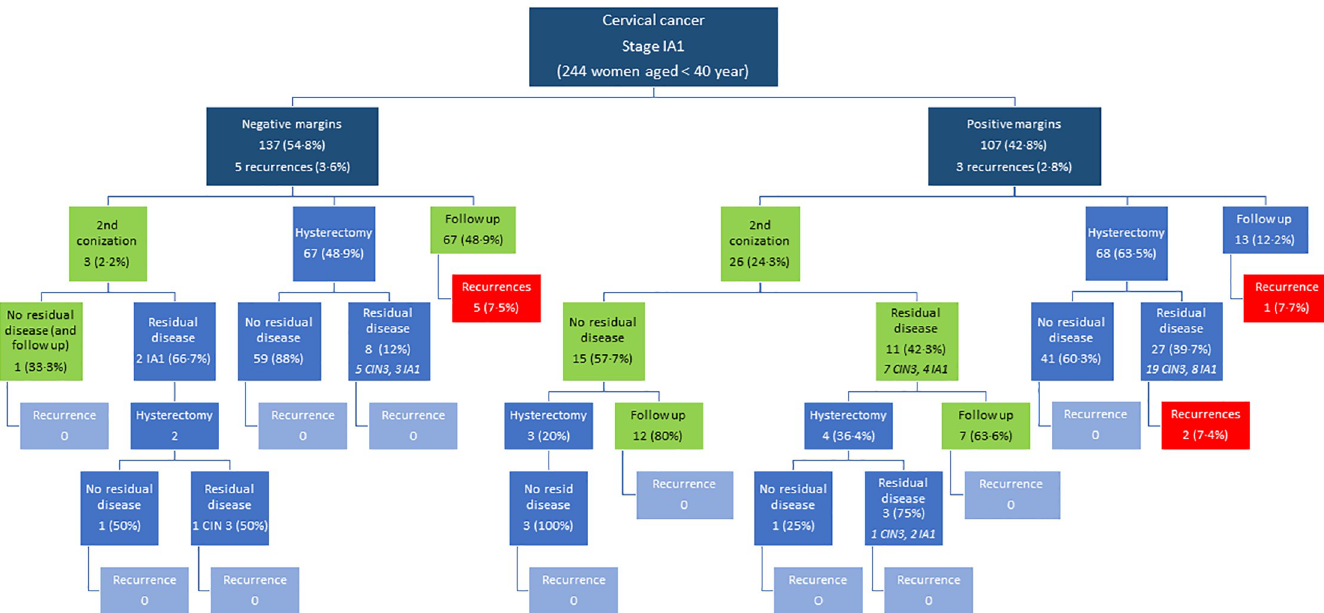
Fig 2. Management of the 551 women with squamous cell carcinoma of the cervix stage IA1 according to surgical margins of the first conization specimen, detection of residual disease, and occurrence of recurrence in the follow-up (conization margins not available in 11 cases).